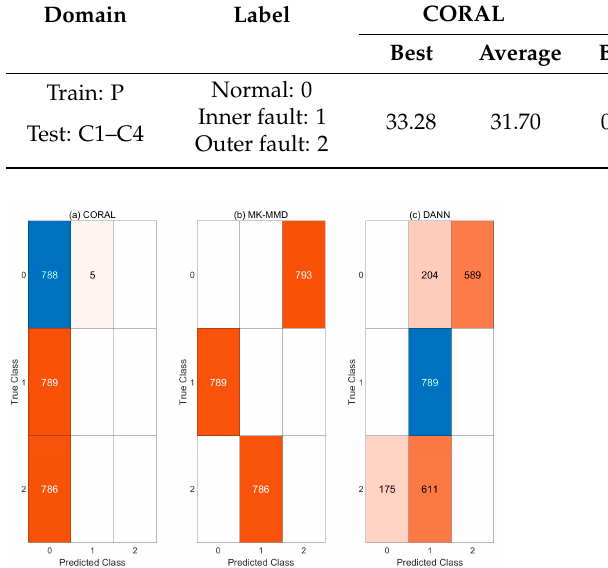
Figure 11. Confusion matrices of case 2: ( a ) CORAL ( b ) MK-MMD ( c ) DANN.